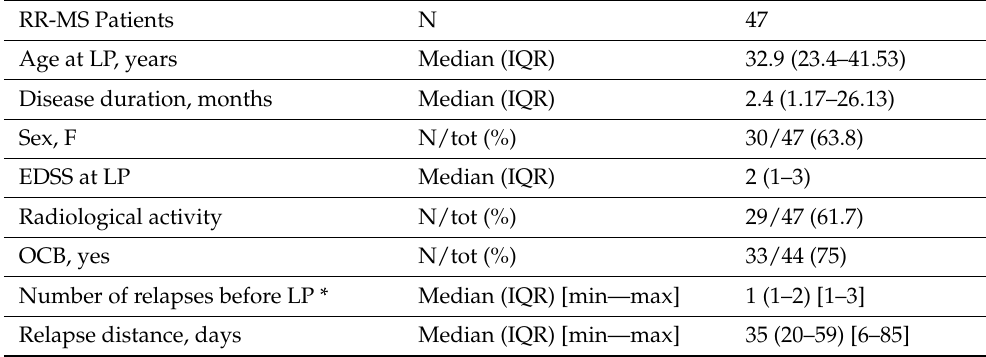
Table 1. Clinical characteristics of RR-MS patients.